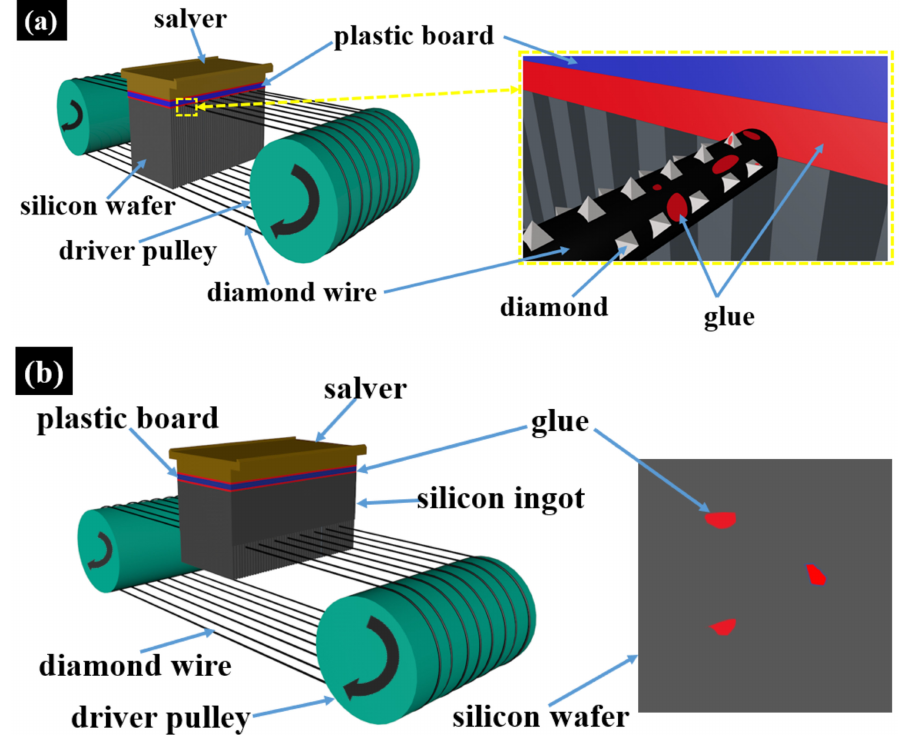
Figure 6. ( a ) Schematic diagram of diamond wire attachment stains, ( b ) schematic diagram of adhesion stains of the silicon